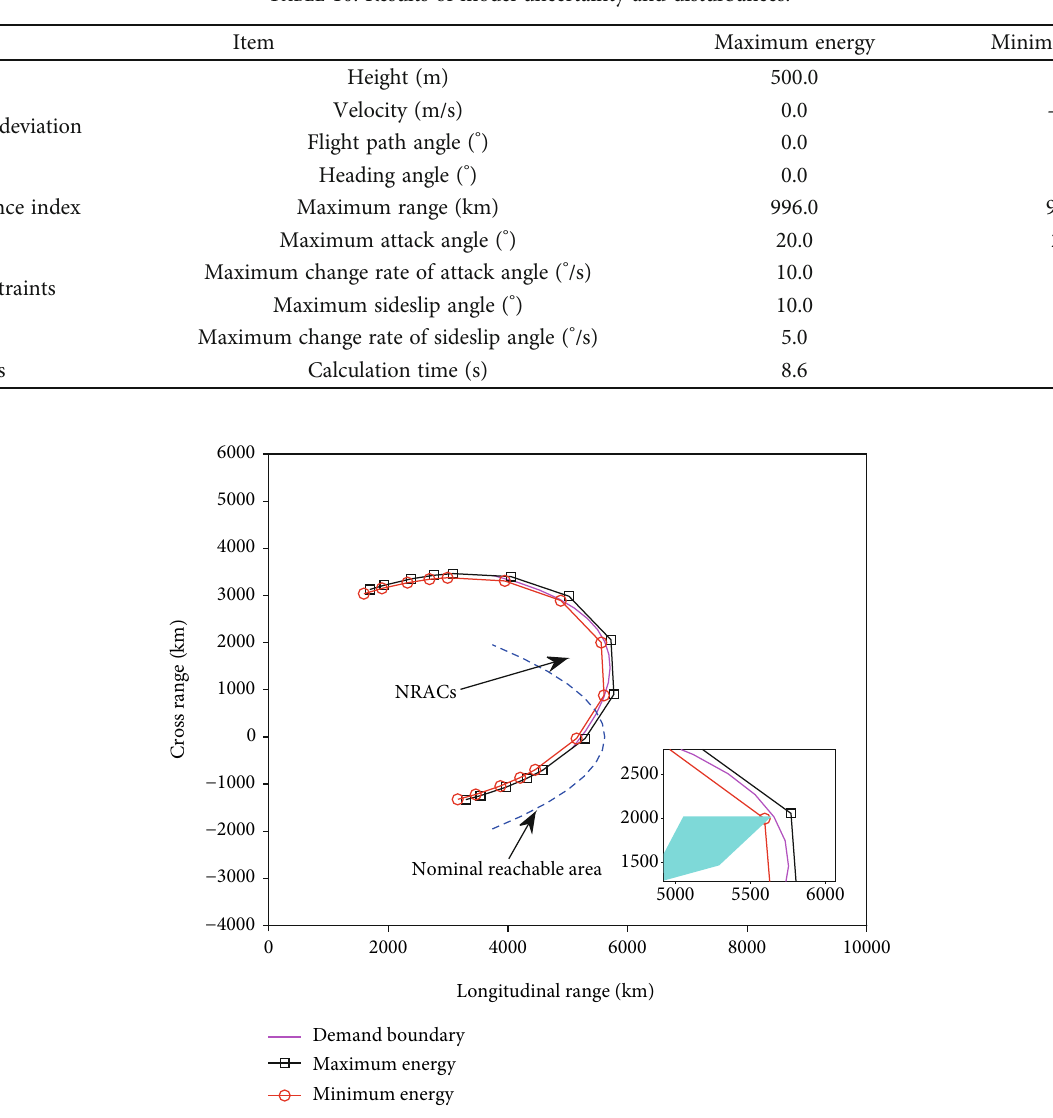
Table 10: Results of model uncertainty and disturbances.